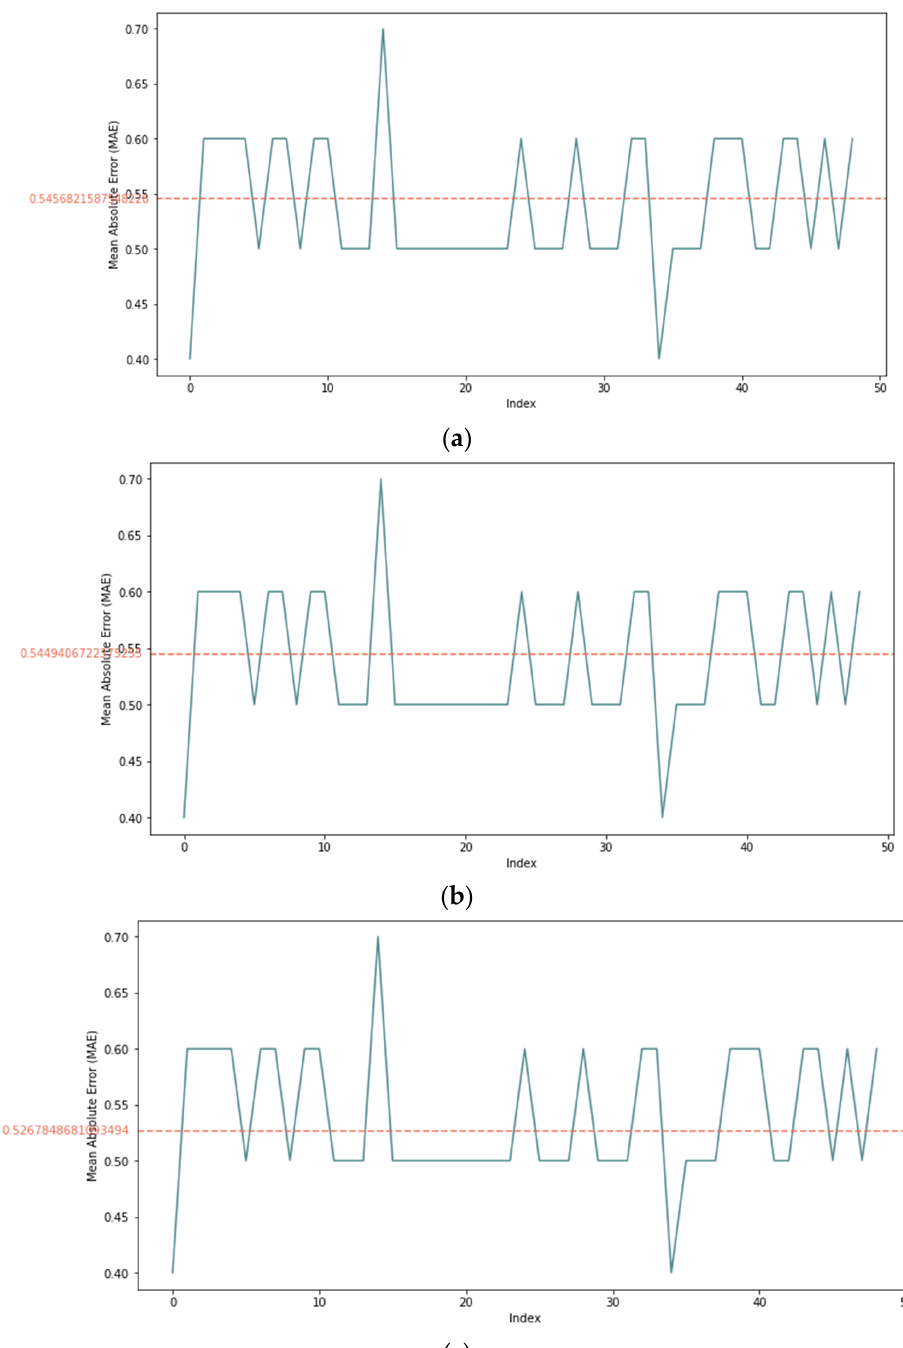
Figure 8. DT results for each sample: ( a ) 25% sample size, ( b ) 50% sample size, and ( c ) 100% sample size.